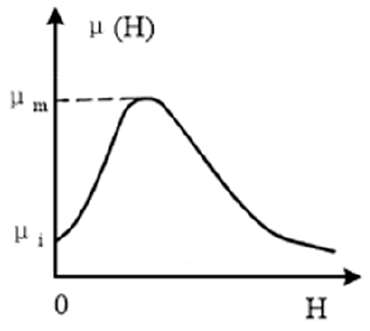
Figure 4. µ (H) Figure 4. μ (H) curve. Figure 4. μ (H) curve.